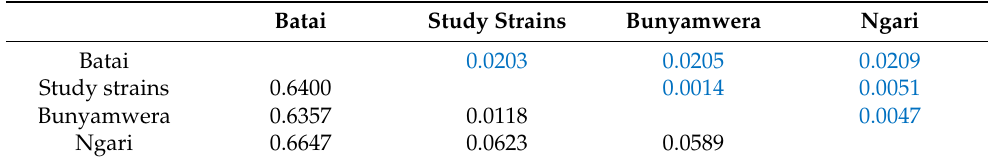
Table 4. Estimates of L segments amino acid similarities between